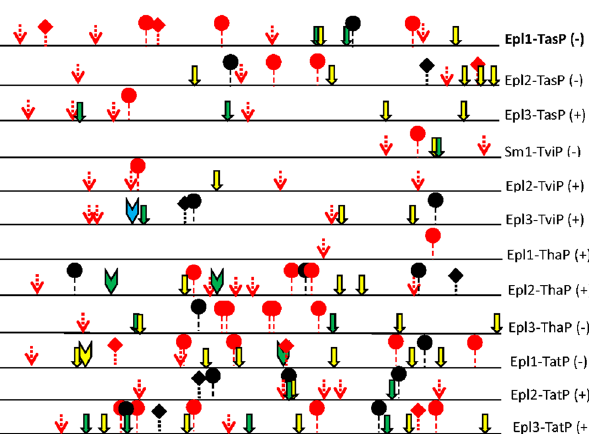
Figure 4. Motif analysis of promoters of Epl1-Tas and its similarity sequences. : putative transcription start site; : WRKY transcript factor binding site, disease resistance (ASF1MOTIFCAMV, S000024); : disease resistance responses (BIHD1OS, S000498); : low temperature responsive element (LTRECOREATCOR15, S000153); : disease mechanism, (WBOXATNPR1, S000390); : MYB transcript factor binding sit, dehydration protein (MYB2CONSENSUSAT, S000409); : Gibberellin (CCAATBOX 1, S000030); : Ethylene responsive element (ERELEE4, S000037); : Salicylic acid responsive element (GAREAT, S000142); : drought response and low temperature responsive element (DRECRTCOREAT,